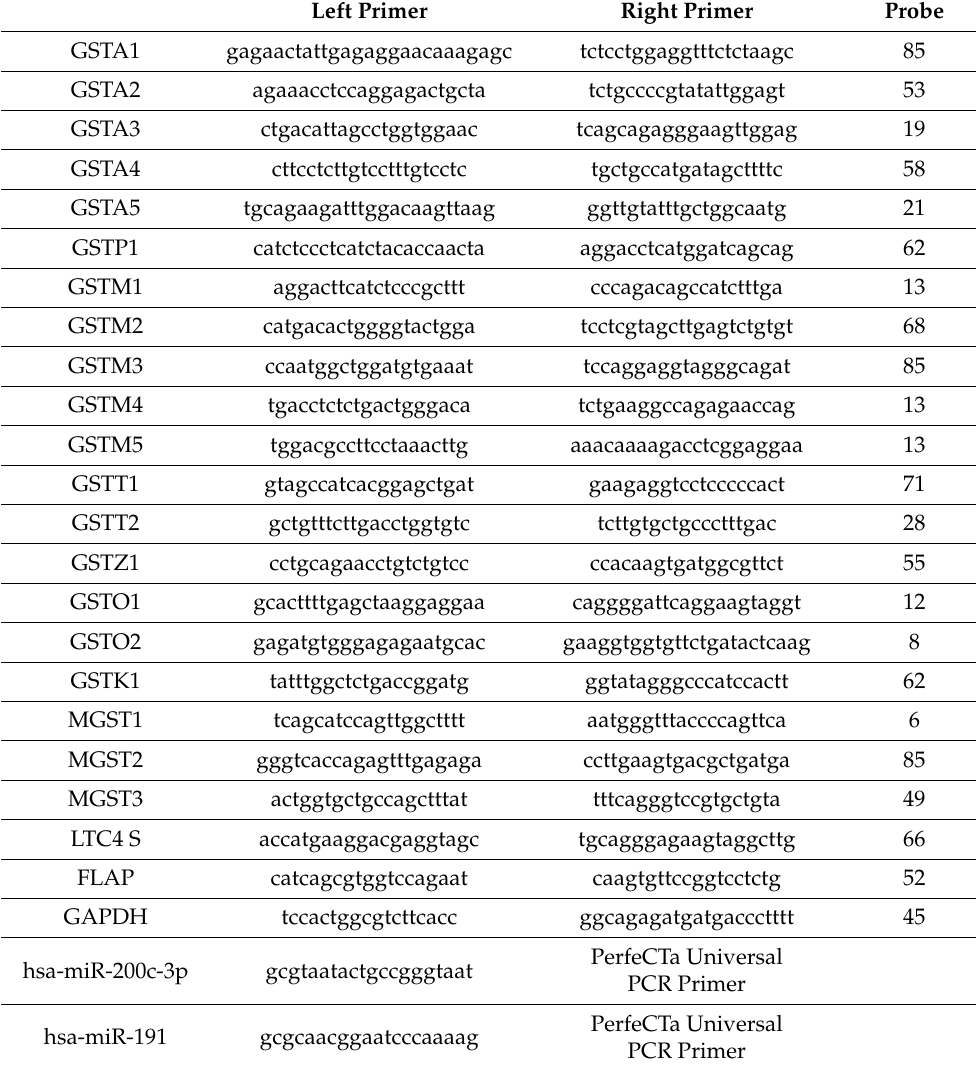
Table A1. Sequences of qRT-PCR primers and TaqMan qRT-PCR analysis. Left Primer Right